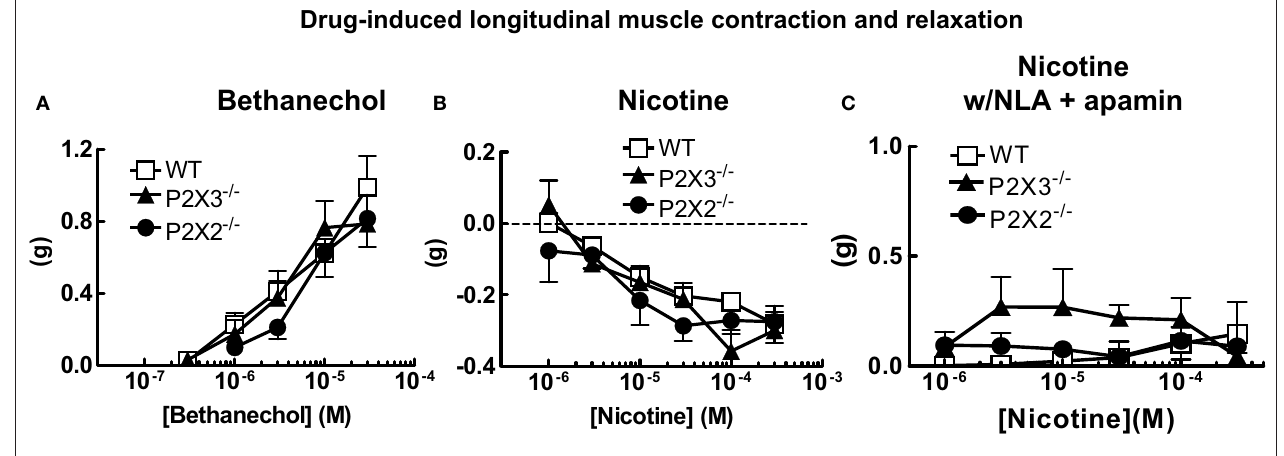
Figure 1 | Cholinergic agonist-induced longitudinal muscle motor responses in the isolated colon of mice. (A) Concentration response curves for bethanechol-induced longitudinal muscle contractions were similar in colonic segments from WT ( n = 21) and P2X2 ( n = 10) and P2X3 ( n = 17) subunit KO mice. (B) Nicotine-induced relaxations of the longitudinal muscle were similar colonic segments from WT ( n = 23) and P2X2 ( n = 14) and P2X3